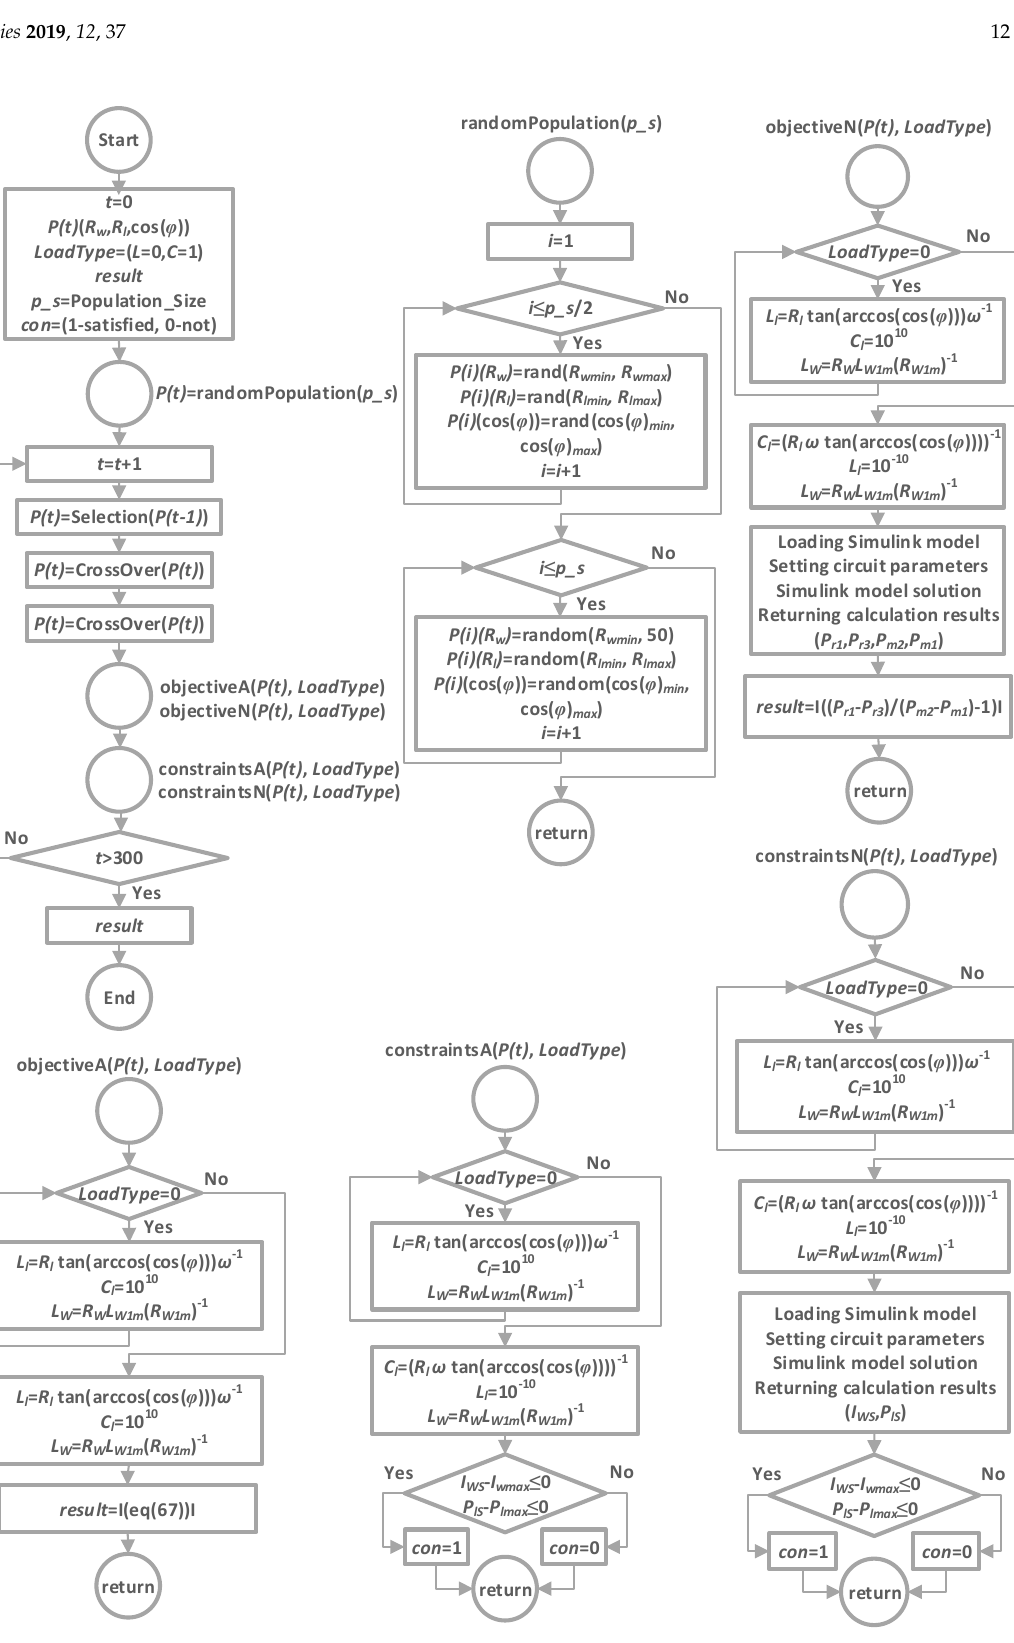
Figure 5. Flowchart of the optimization algorithm (GA case).